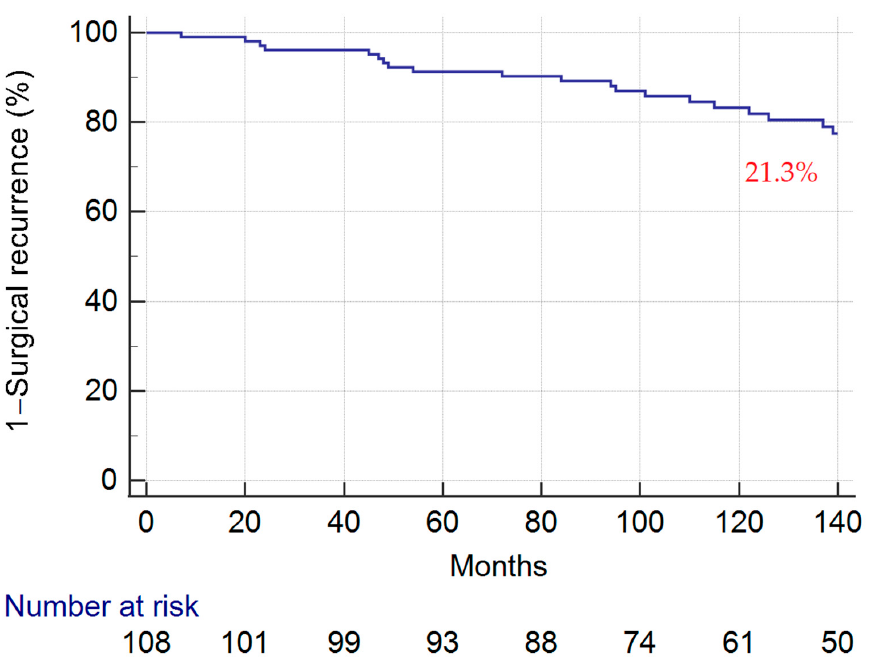
Figure 1. Cumulative surgical recurrence rates calculated using the Kaplan–Meier method. In the univariate analysis, we observed different cumulative incidences of surgical recurrence according to age at CD diagnosis ≤ 27 years (Log-rank test, p = 0.040), age at first surgery ≤ 28 years (Log-rank test, p = 0.001), current smoking status (Log-rank test, p = 0.001), and administration of systemic steroids after surgery (Log-rank test, p = 0.002) (Figure 2). Interestingly, in the multivariate Cox regression analysis, we observed that an age ≤ 28 years at the first surgical resection (aHR = 16.44, p < 0.001), current smoking (aHR = 15.84, p < 0.001), female sex (aHR = 7.58, p < 0.001), cryptitis (aHR = 0.02, p < 0.001), pres- ence of granulomas at the local lymph nodes (aHR = 12.19, p < 0.001), and treatment with systemic corticosteroids after the first surgical resection (aHR = 7.52, p = 0.002) were factors significantly associated with the risk of surgical recurrence (Table 2).